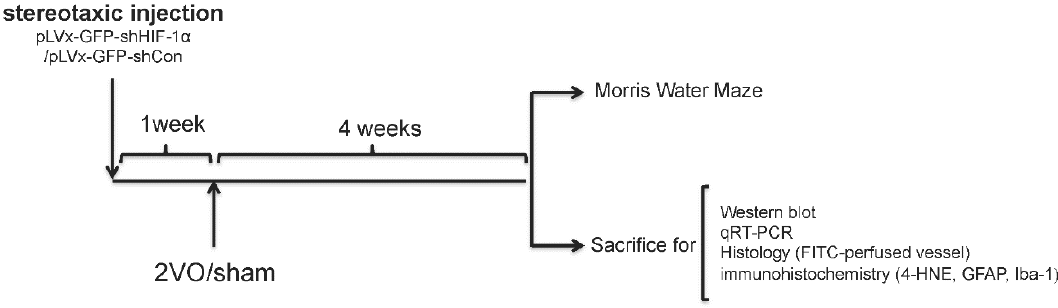
Figure 8. Experimental designs of the present study.